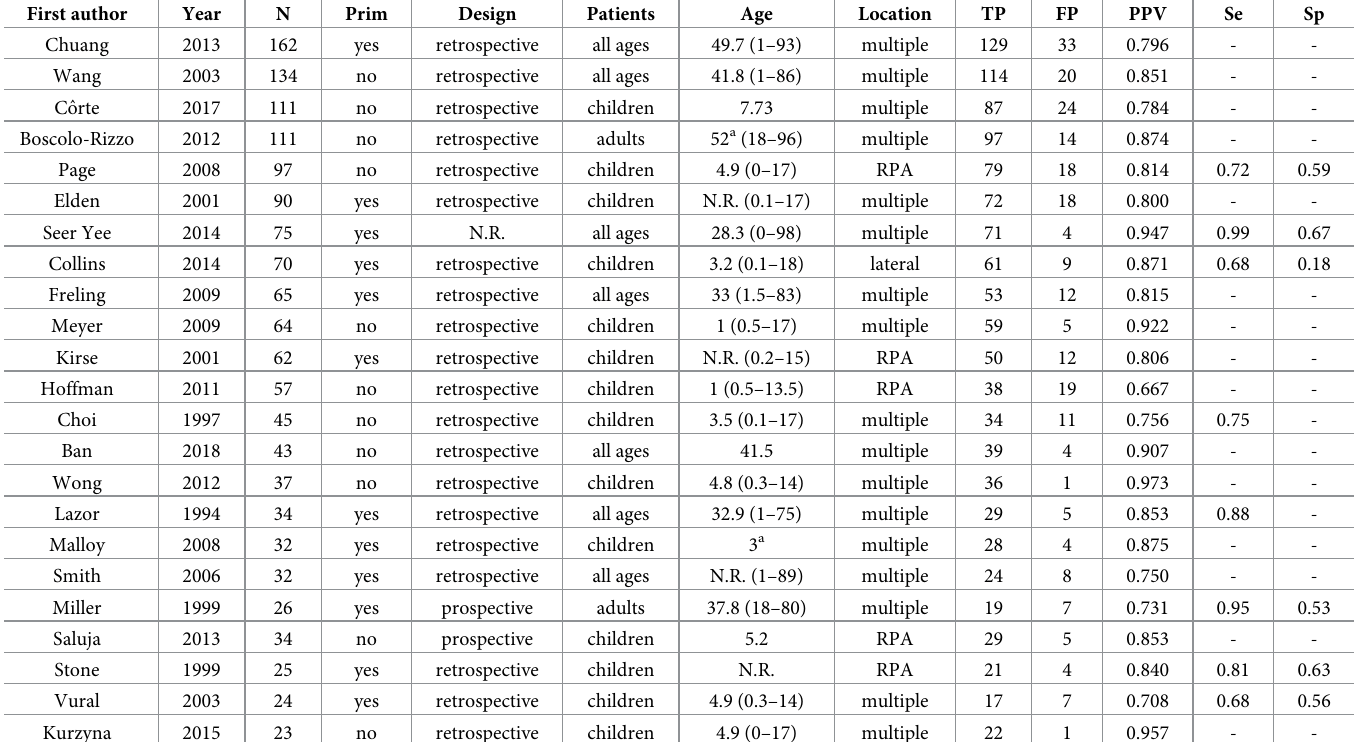
Table 1. Studies included in the